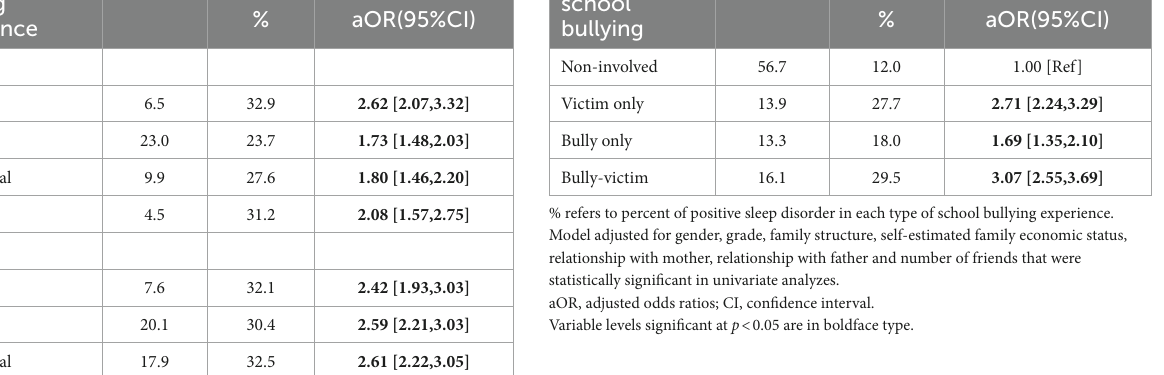
TABLE 2 Multivariate logistic regression between individual type of school bullying and adolescent sleep disorder ( N = 5,724). Type of school bullying